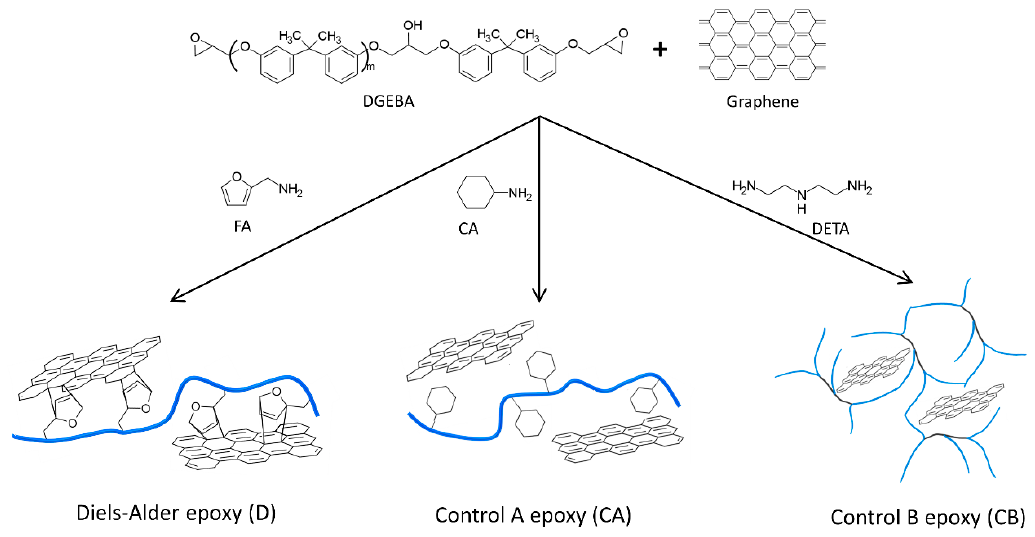
Polymers 2019 , 11 , x FOR PEER REVIEW Figure 4. Schematic of the three types of GNP/EP nanocomposite systems. Figure 4. Schematic of the three types of GNP / EP nanocomposite systems.